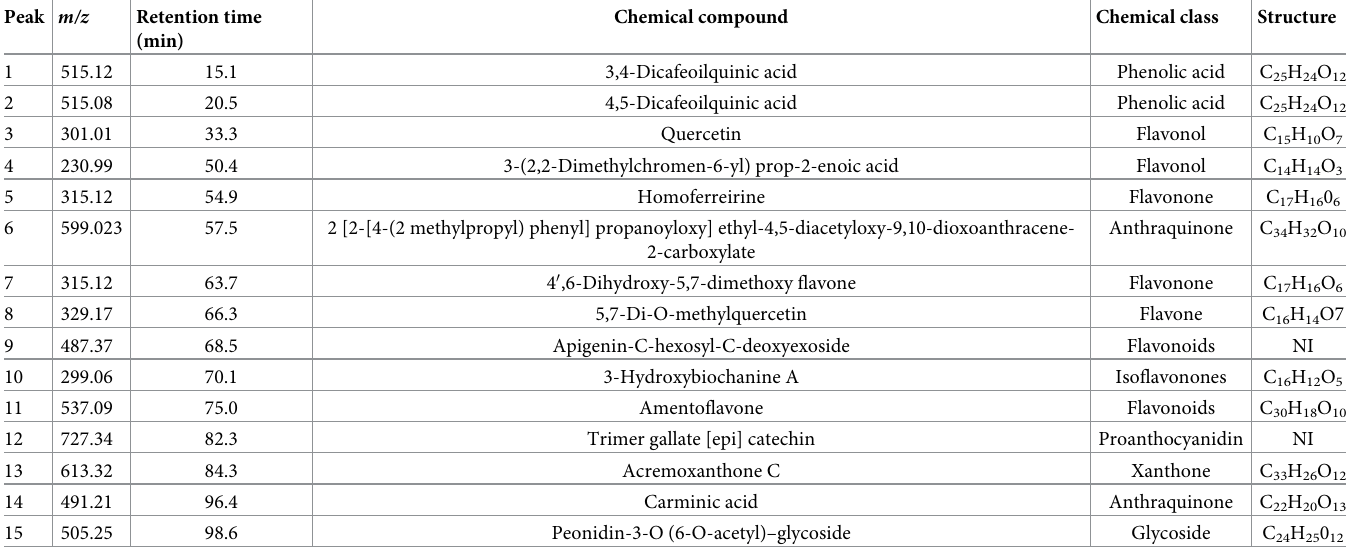
Table 3. Chemical compounds, mass, and retention time of compounds identified in green propolis by HPLC-DAD-MS. Peak m/z Retention time (min)